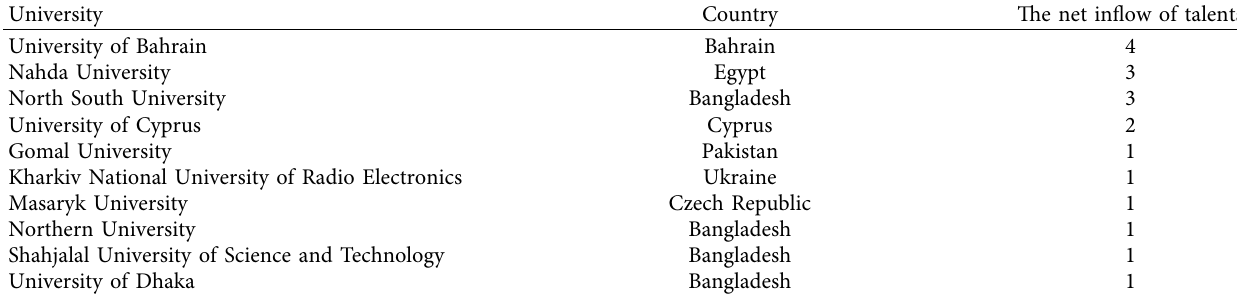
Table 2: The ranking of the attractiveness for undergraduates to continue their studies (top 10).